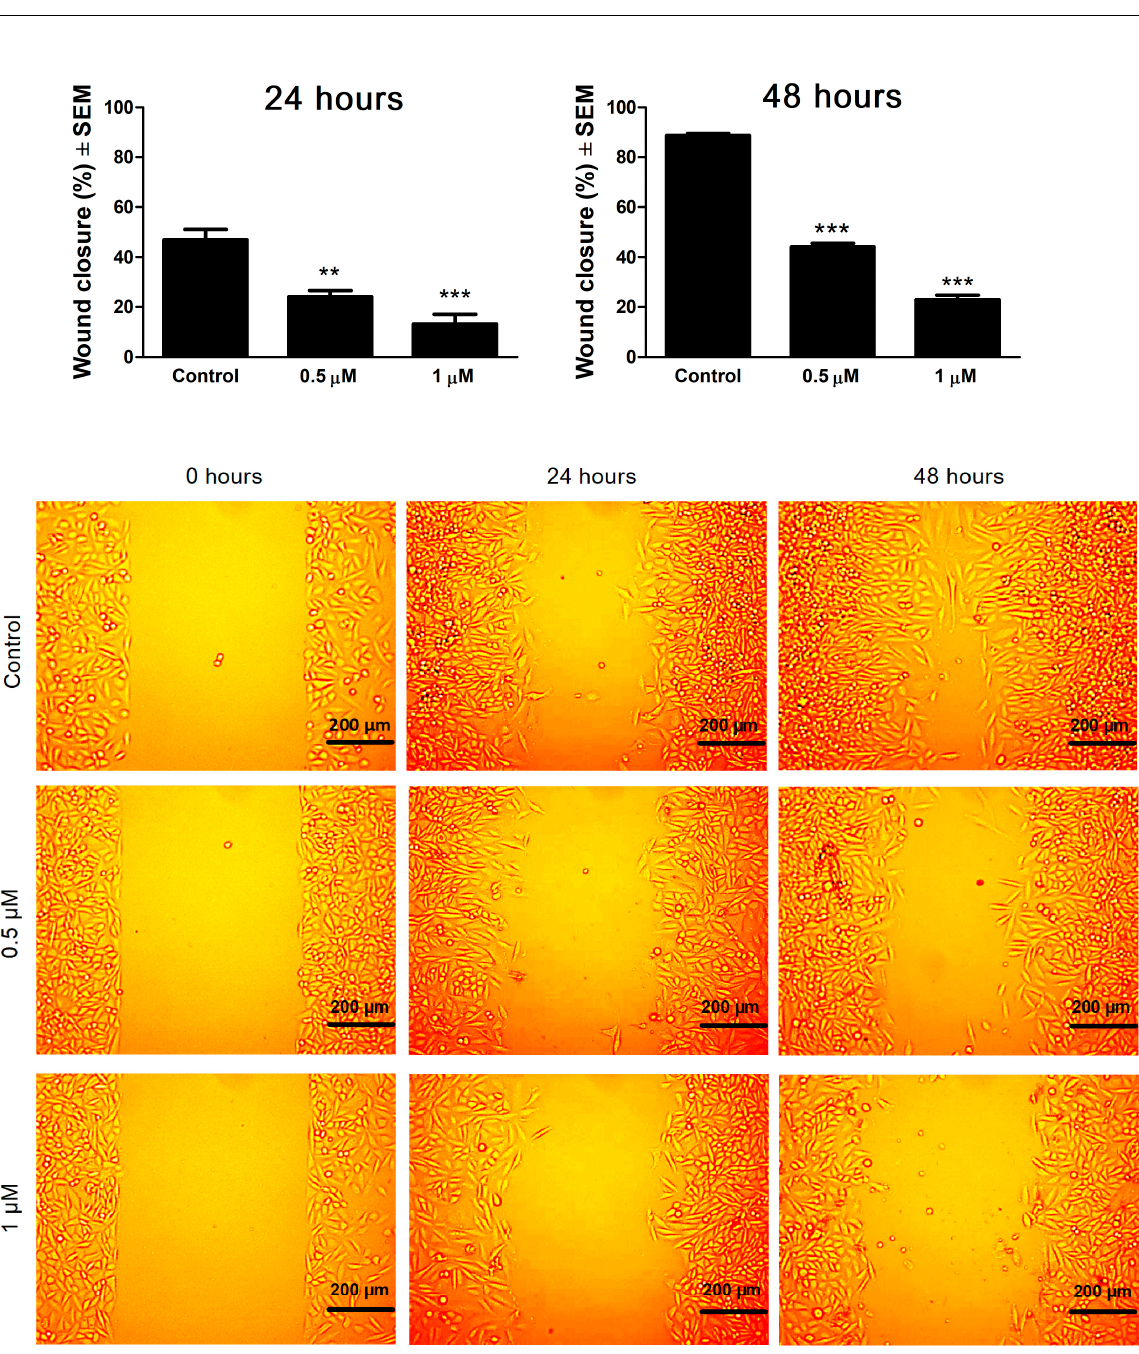
Figure 7. Cell migration (wound healing) assay. Upper panels : effects of 13AES3 on SiHa cell migration at 24 and 48 h post-treatment. Lower panel : representative images of the antimigratory effects of 13AES3 at 0, 24 and 48 h post-treatment. ** and *** indicate significance at p < 0.01 and p < 0.001, respectively.